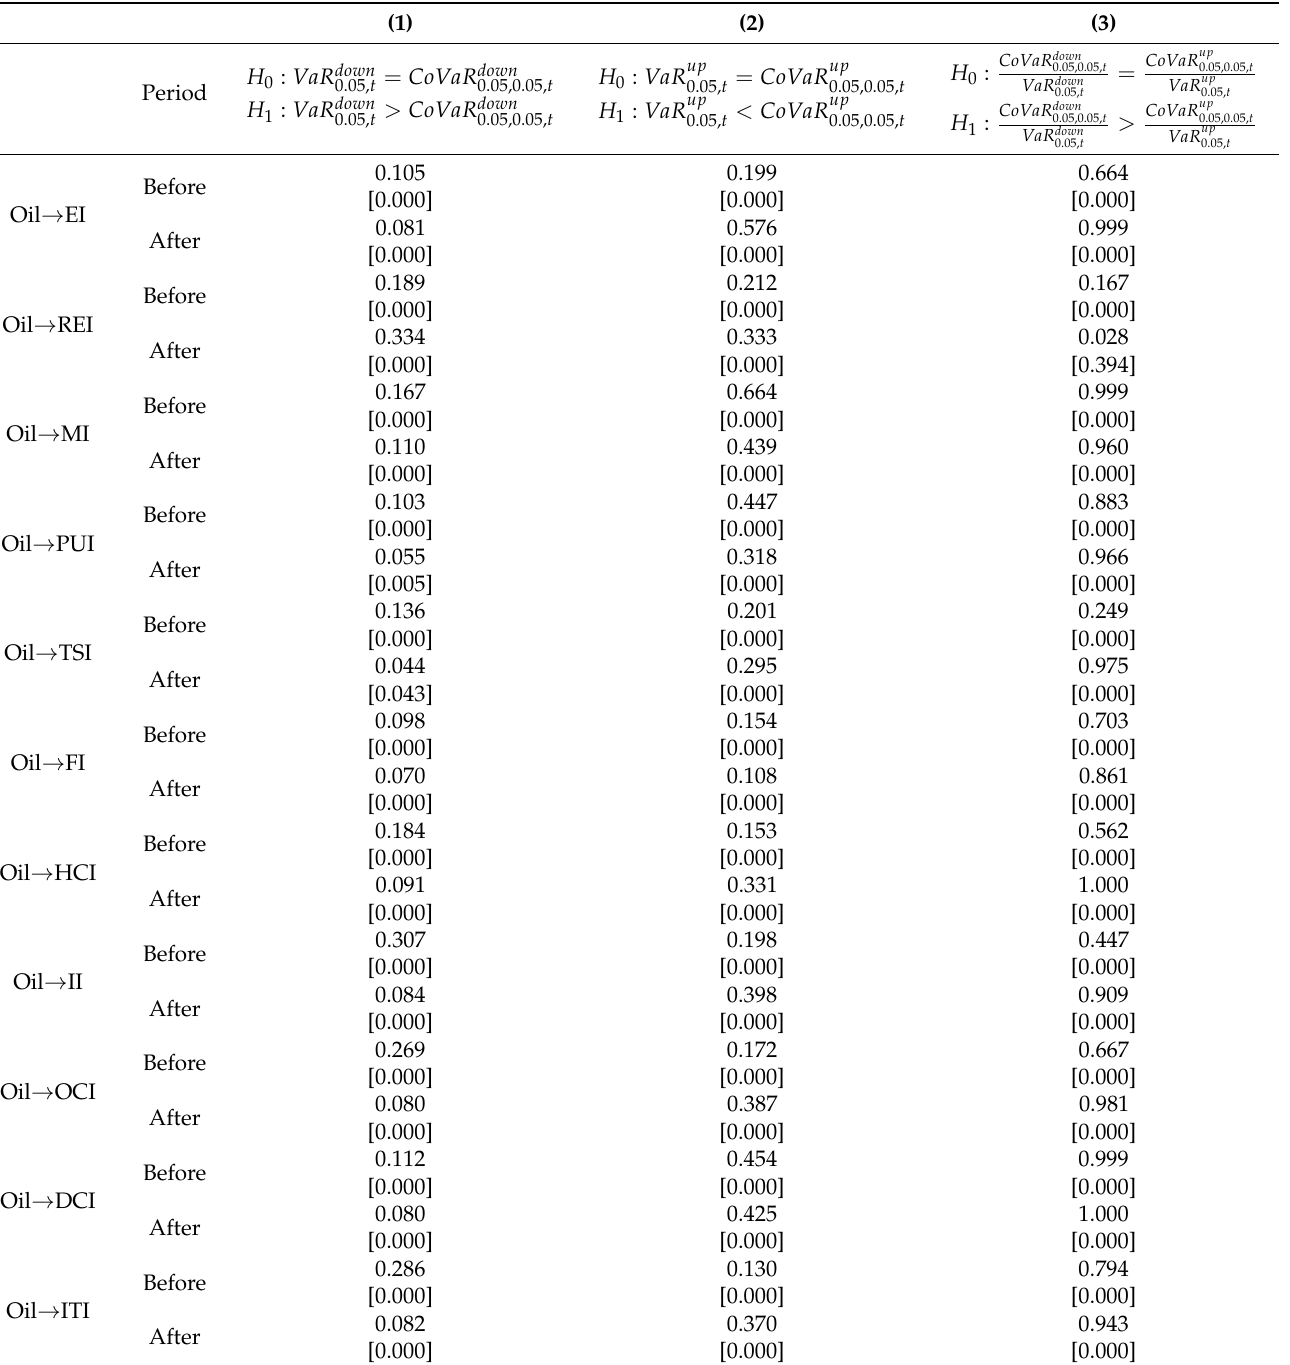
Table 7. Hypothesis testing for tail risk spillover of extreme oil market on Chinese sector stock